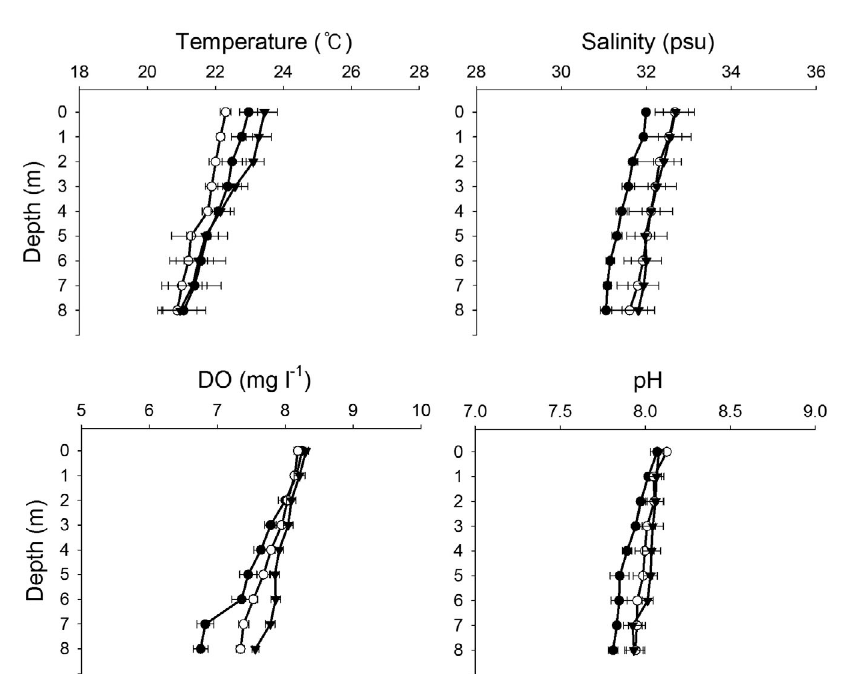
Fig. 3. Vertical profiles of the major environmental variables at the study sites af- ter the oxycline. Solid circles: hypoxic site 1 (HS-1); empty circles: hypoxic site 2 (HS-2); solid triangles: reference site (RS). Data are means ±